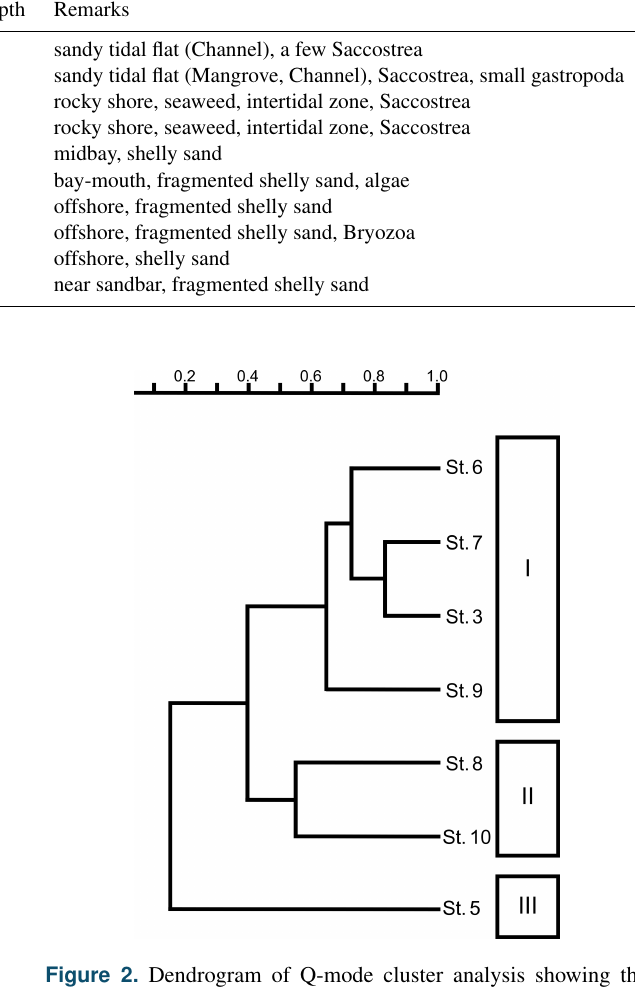
Table 1. Location and habitat information for the nine stations in this study. St.